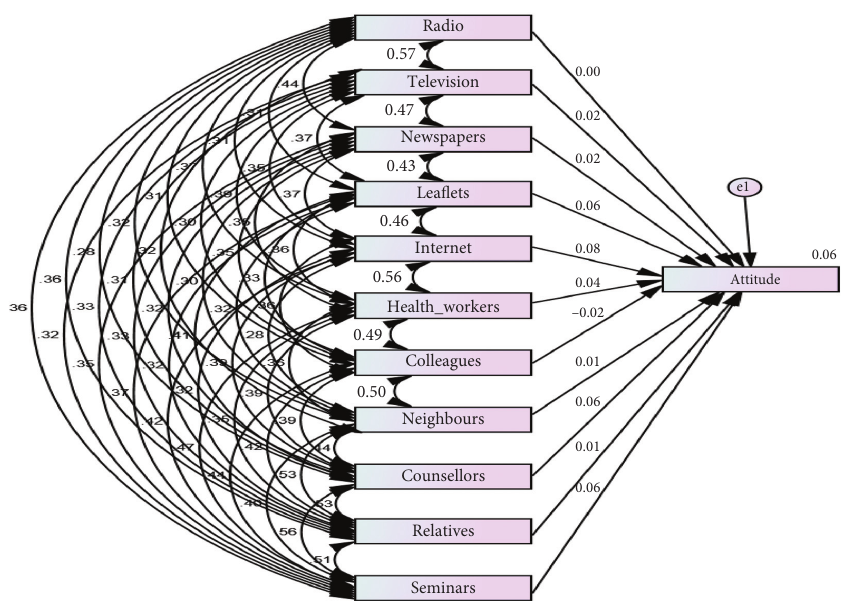
Figure 2: Health communication channels and residents’ attitudes on the hepatitis B virus management model. Table 5: Standardised regression weights of health communication channels and attitude of residents on hepatitis B